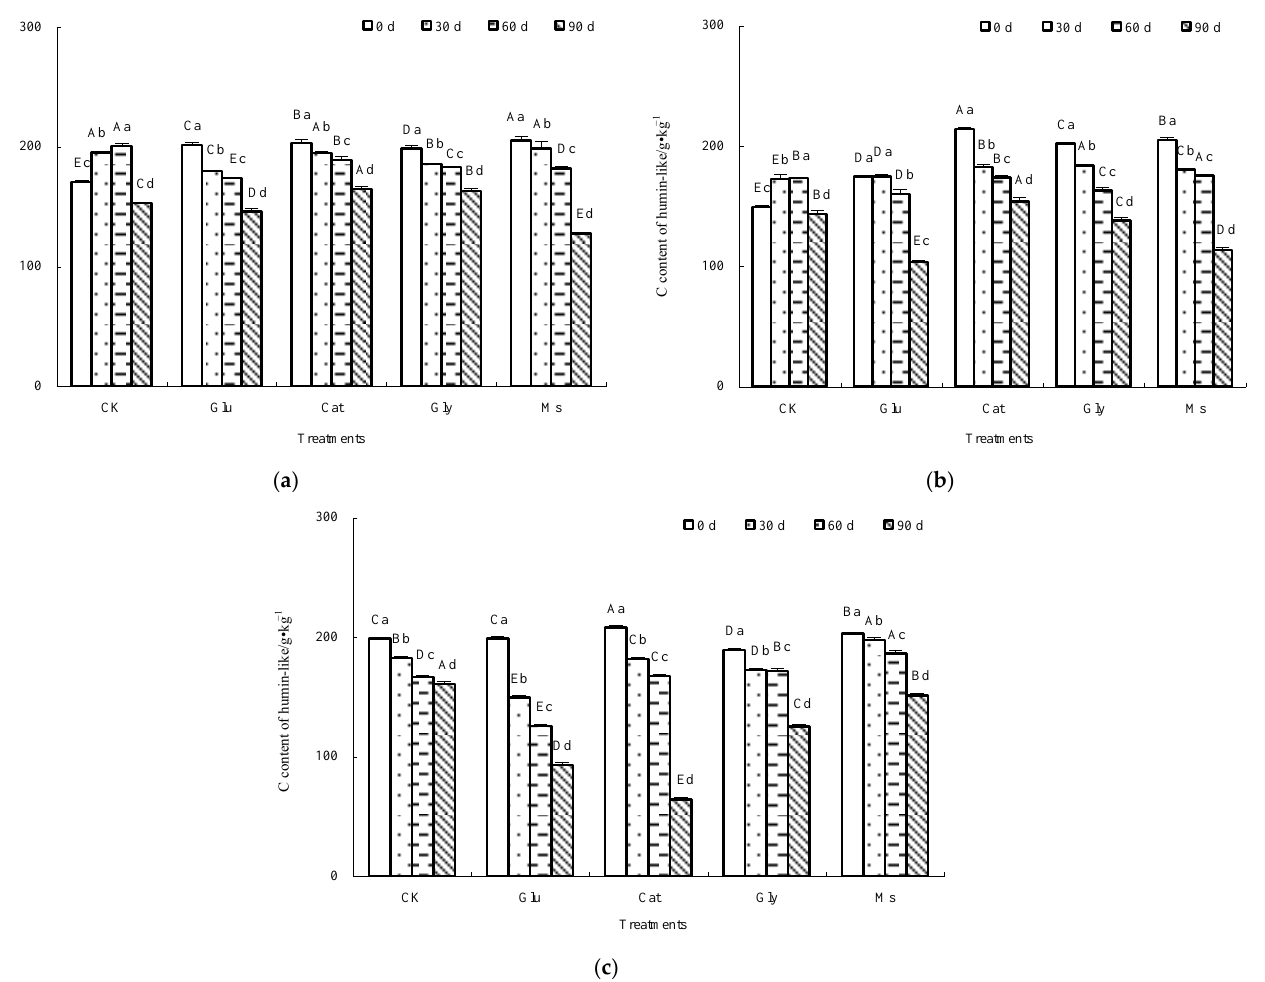
Figure 5. Effect of Maillard reaction precursors on C HLu extracted from the decomposing material of rice straw at different incubation temperatures. Note: significant difference in the different treatments with the same number of incubation days is indicated by different capital letters, and significant difference in the different incubation days under the same treatment is expressed by different lowercase letters. ( a ) Incubated at 10 ◦ C; ( b ) incubated at 15 ◦ C; ( c ) incubated at 28 ◦